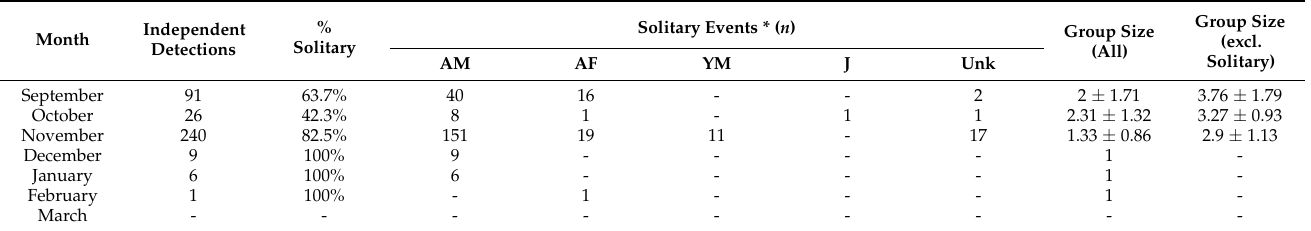
Table 4. Number of solitary and group mouflon events (independent) and mean group size per month.